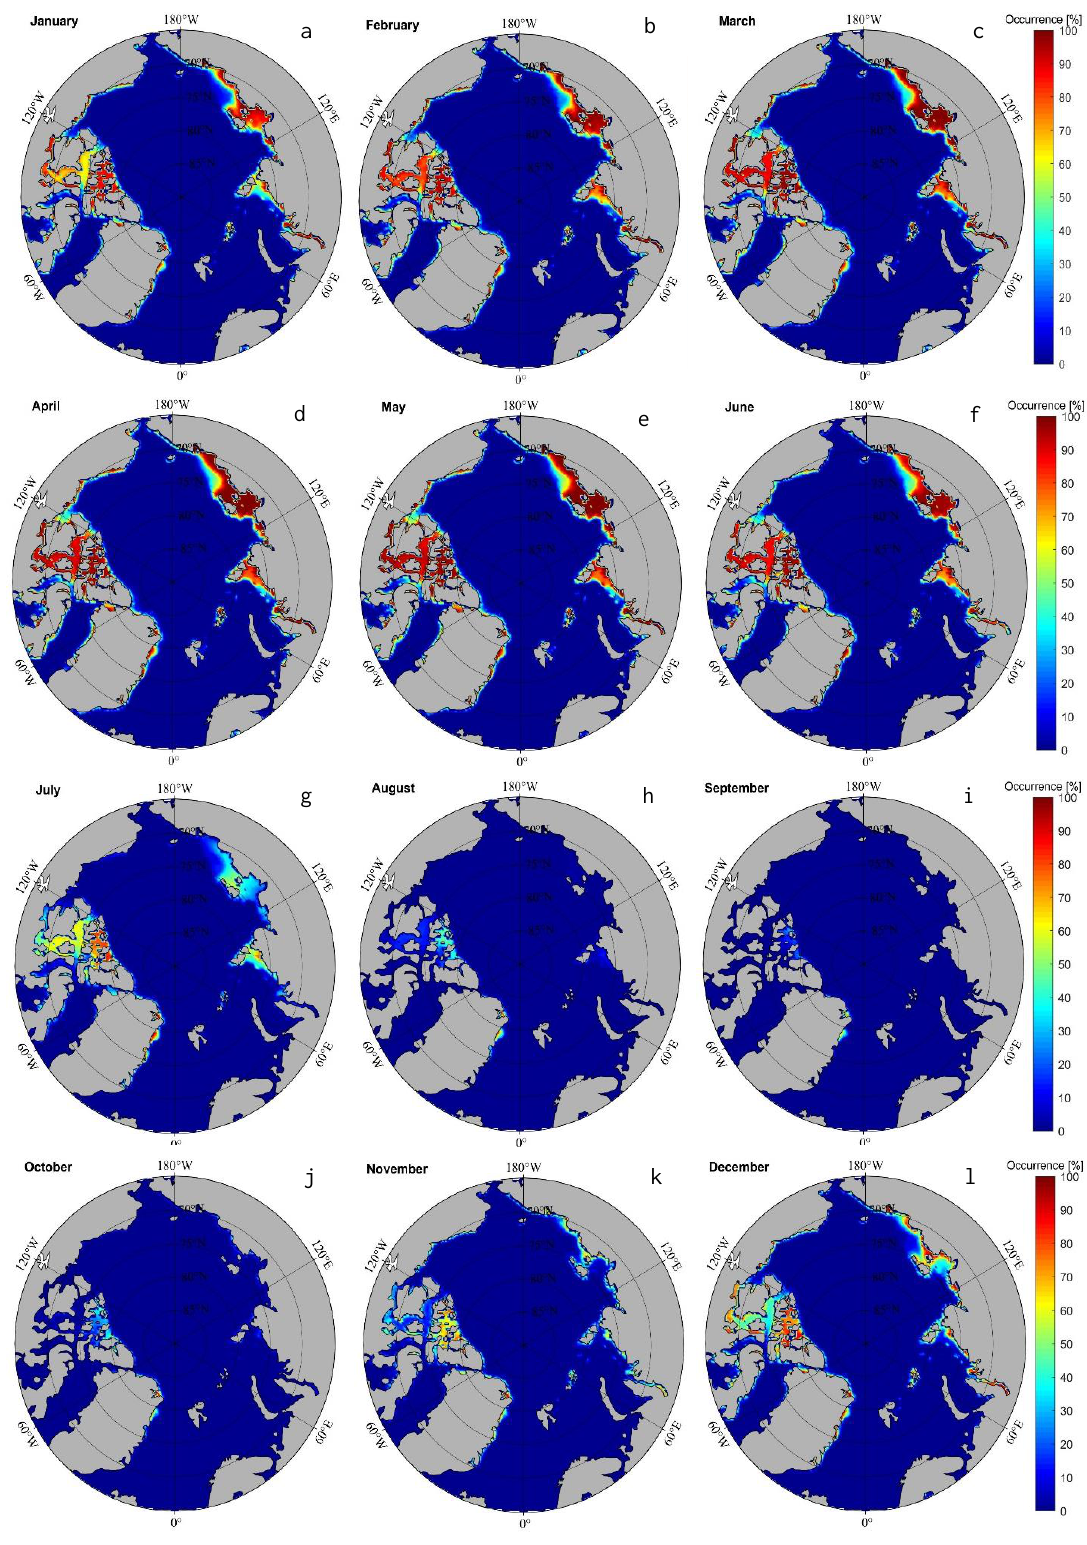
Figure 3. Monthly landfast ice occurrence from January to December. The different colors represent the percentage of the number of yearly landfast ice existing during the 43-year time series from 1976– 2018.